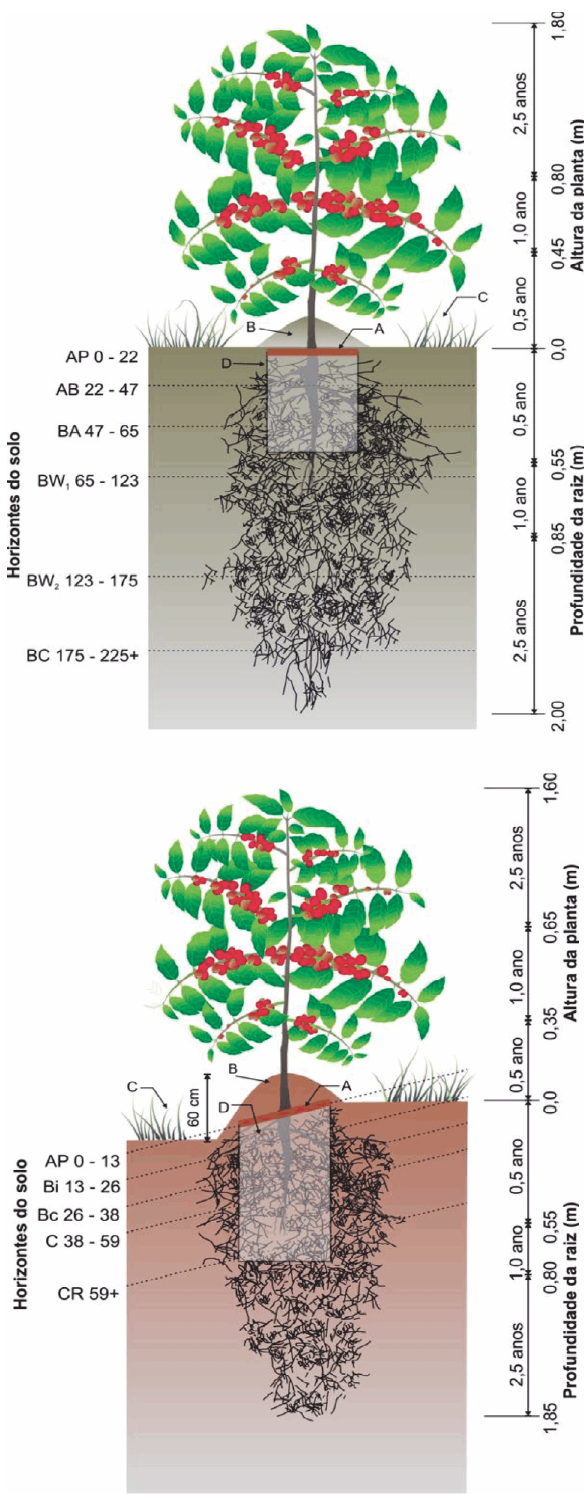
Figura 1. Representação esquemática de cafeeiro sob sistema de manejo intensivo de cultivo, em área de Latossolo (inferior) e de Cambissolo (superior), em que: (A) camada de gesso; (B) leira de terra na base das plantas; (C) braquiária na entrelinha; e (D) sulco de